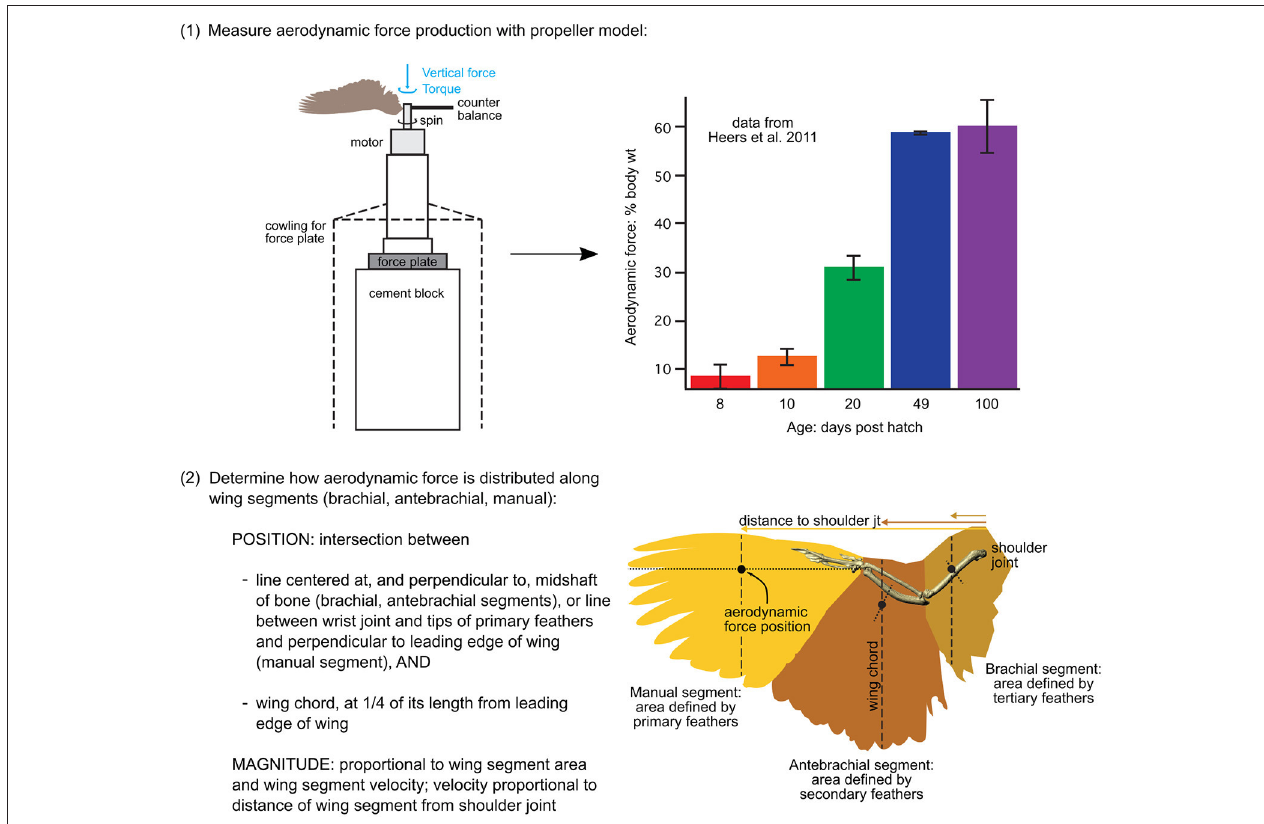
FIGURE 3 | Aerodynamic force calculations. Stepwise procedure showing how the magnitudes and positions of aerodynamic forces were calculated for each model. Data in the graph is from Heers et al. (2011); the drawing of the propeller apparatus is modified from Crandell and Tobalske (2011). Resulting model inputs are shown in Table S3